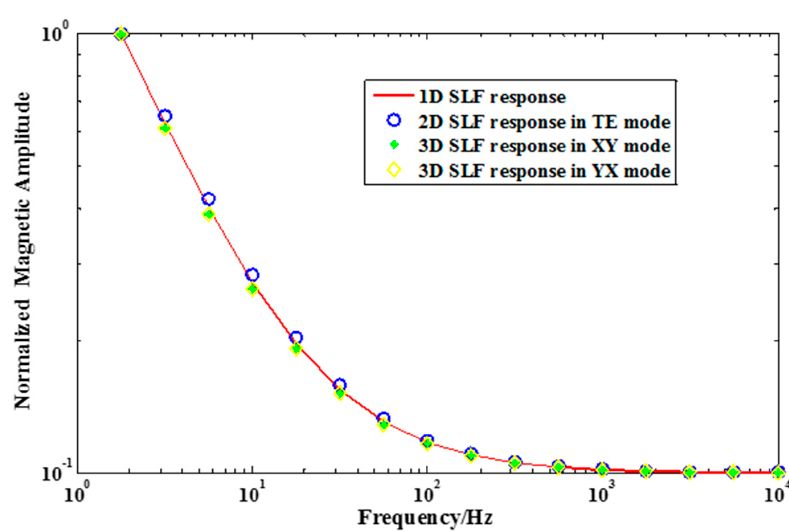
Figure 2. 1-D, 2-D, and 3-D magnetic amplitude responses of the four-layer model. Note: 1-D, 2-D, and 3-D in the figure represent one-dimensional, two-dimensional, and three-dimensional, respectively. The ordinate represents the normalized magnetic amplitude response, and the abscissa is the frequency.